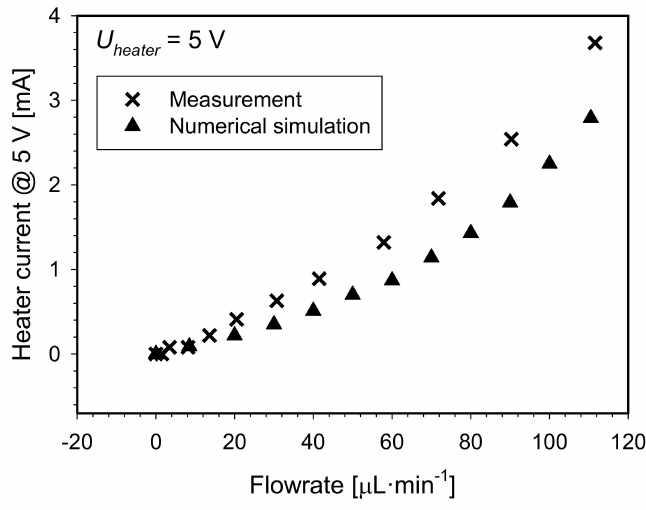
Figure 16. Measured and simulated heater current versus flowrate for H/S configuration.